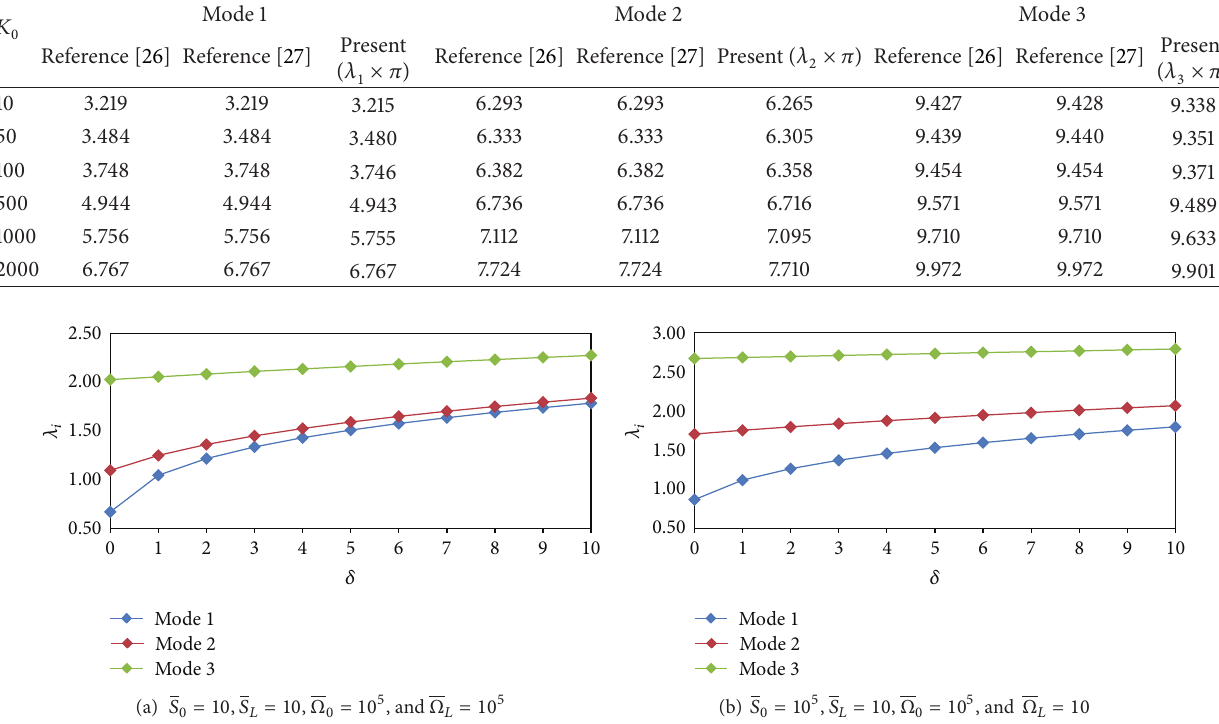
Figure 2: The effects of different spring parameters on the vibration frequencies.